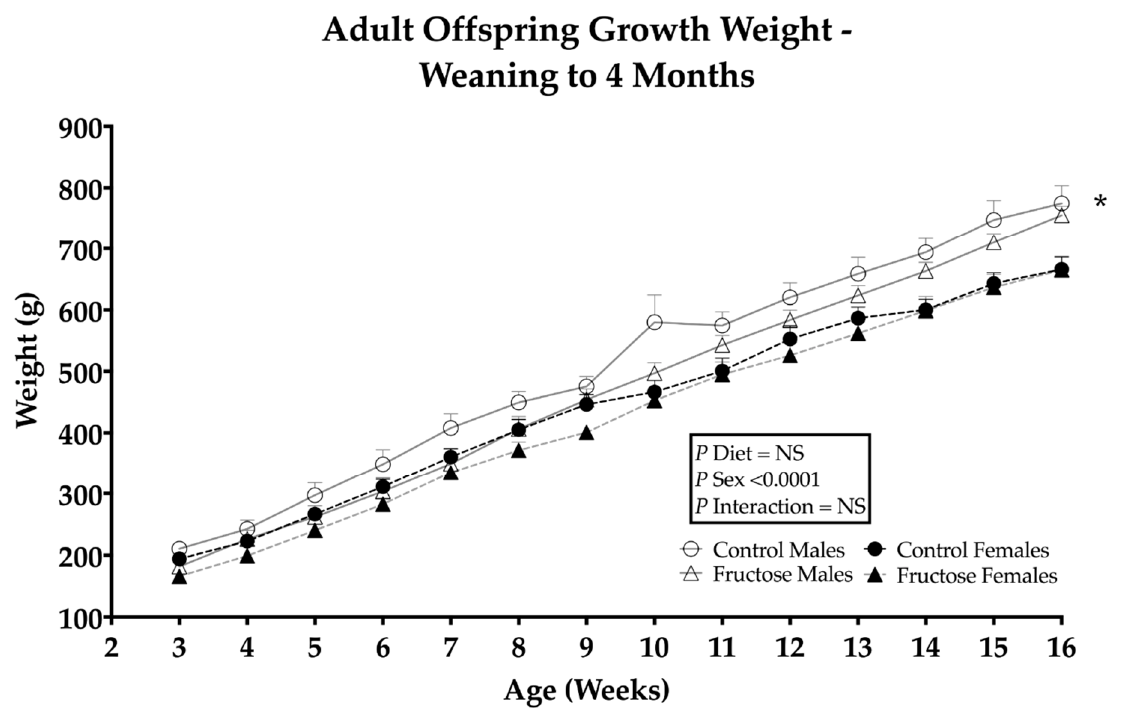
Figure 1. Weanling (D21) to adult (4M) offspring weight gain from week 3 to week 16. CD males ( n = 7); FD males ( n = 7); control females ( n = 7) and fructose females ( n = 7). Significant effects were shown in the sex of offspring weight gain. All data were analysed using a 2 × 2 factorial design with repeated measures GEE, diet*sex*time*interaction included as factors (general analysis of variance) using IBM SPSS statistics 25. Data presented as group mean ± SEM. * denotes significance of p < 0.0001.